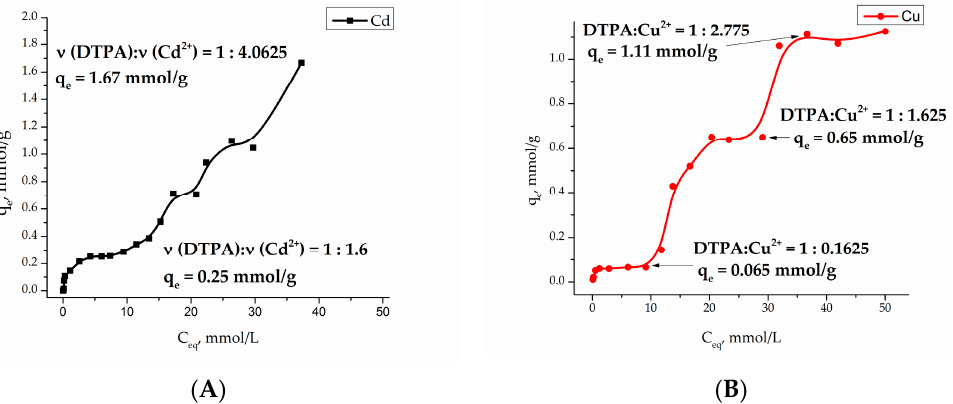
Figure 4. Adsorption isotherms of Cd (II) ( A ) and Cu (II) ( B ) on Fe 3 O 4 /SiO 2 -NH 2 -DTPA nanocomposite.